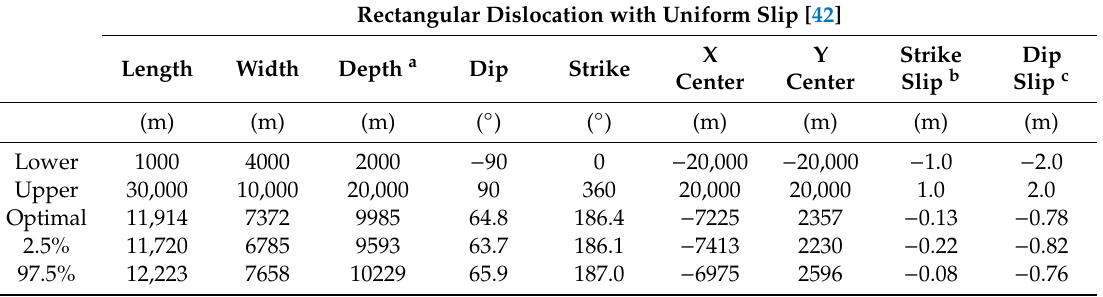
Table 2. Prior and inversion results for the 2020 Yutian earthquake.